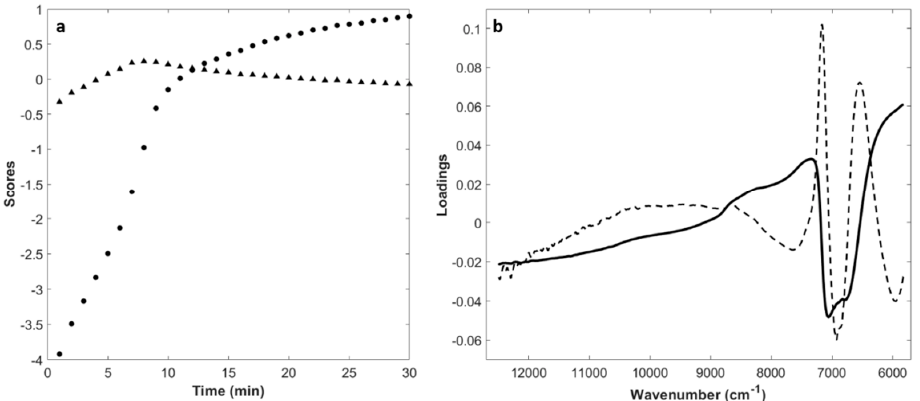
Figure 2. Principal component analysis results of the SNV transformed and centered FT-NIR spectra collected for one milk renneting batch developed under normal operating conditions (NOC 13a ): temperature, 35 ◦ C; milk pH, 6.5; fat content, 2.55 g / 100 mL. ( a ) plot of PC1 ( ● ) and PC2 ( ▲ ) scores vs time; ( b ) PC1 (solid line) and PC2 (dashed line) loading plot.